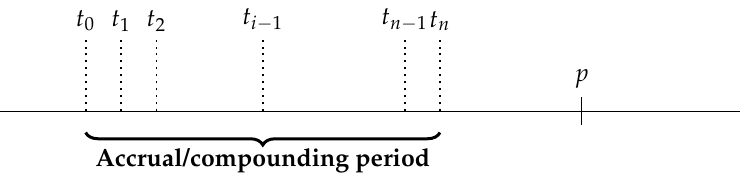
Figure 3. Representation of the dates associated to an